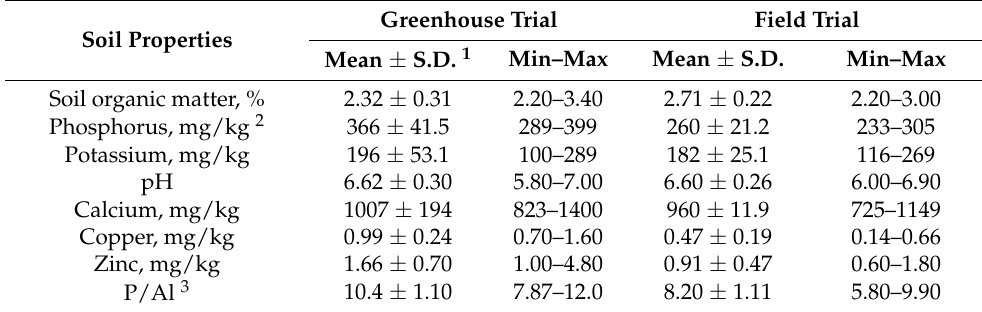
Table 4. Summary statistics of the pre-sowing soil health parameters of soil used in the greenhouse and field trials.